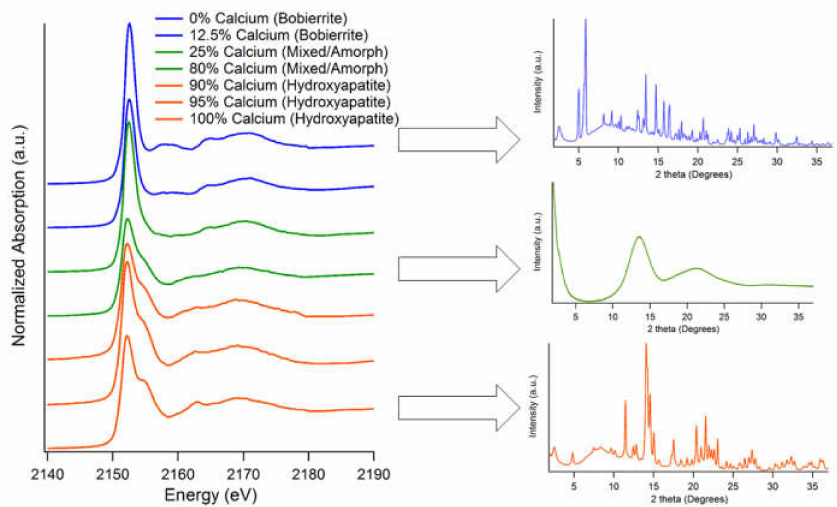
Figure 3. Hydroxyapatite / amorphous calcium phosphate / bobierrite P K-edge XANES and XRD, Blue spectra / patterns indicate magnesium phosphates, green spectra indicate minerals formed in mixed cation solutions with unique characteristics (i.e., ACP), and orange spectra are crystalline calcium phosphates. Percentages refer to initial solution conditions during synthesis.